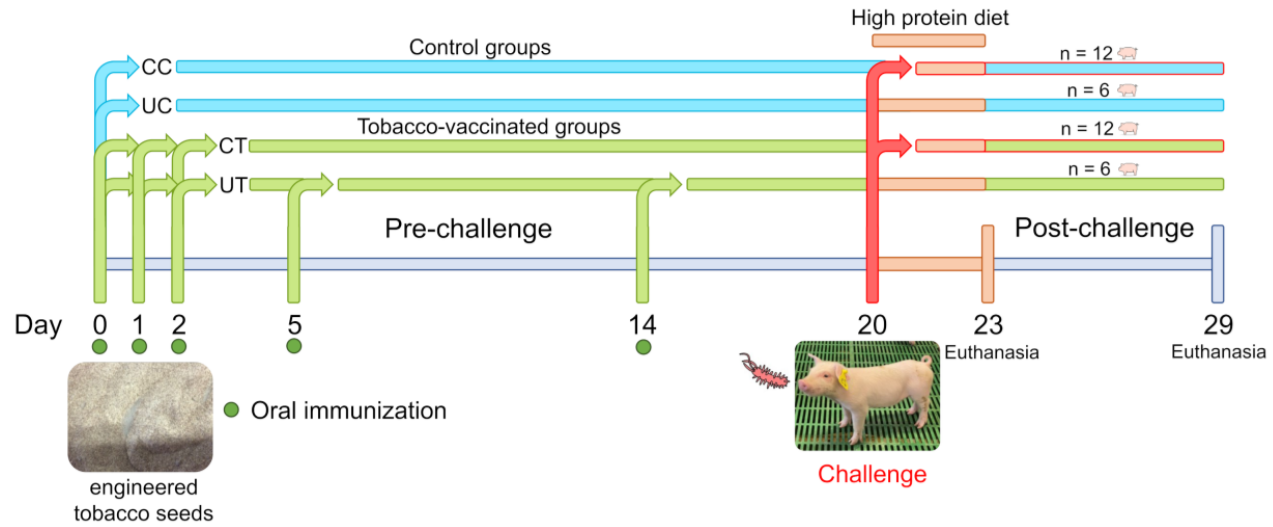
Figure 4. Experimental design from 0 to 29 days divided by immunization phase (pre-challenge) and post-challenge. C: control group fed wild-type tobacco seeds, T: treatment group fed engineered tobacco seeds, CC: challenged control group, UC: unchallenged control group, CT: challenged treatment group, UT: unchallenged treatment